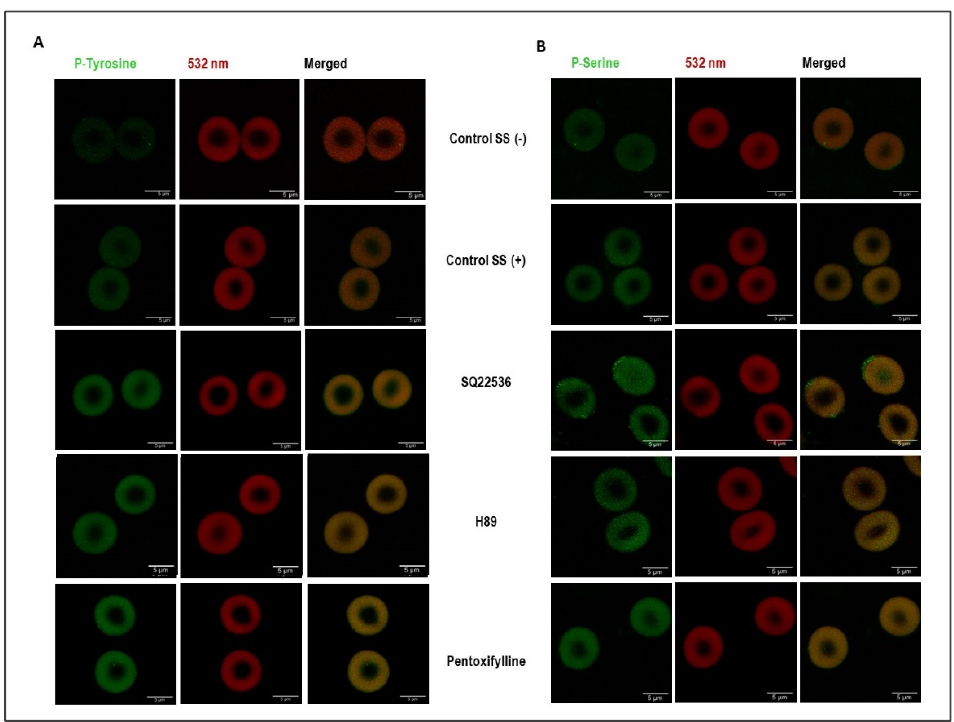
3.3. Shear Stress and cAMP/PKA Signaling Induce Changes in Phosphorylation The shear stress exposure induced a significant increase in both serine and tyrosine phosphorylation of the intact cells (Figure 4). PKA inhibition by H89 dihydrochloride in- creased tyrosine phosphorylation relative to the controls; however, serine phosphoryla- tion was approximately the same as the sheared control. The inhibition of adenylyl cyclase by SQ22536 induced phosphorylation in both serine and tyrosine residues compared to the controls. The inhibition of PDE by pentoxifylline substantially increased tyrosine phosphorylation compared to the controls (Figure 4A). However, the pentoxifylline treat- ment did not change serine phosphorylation compared to sheared control (SS+) (Figure 4B). Phosphorylation status in intact RBCs by different drug treatments before 5 Pa SS exposure is shown in Supplementary Figure S3.